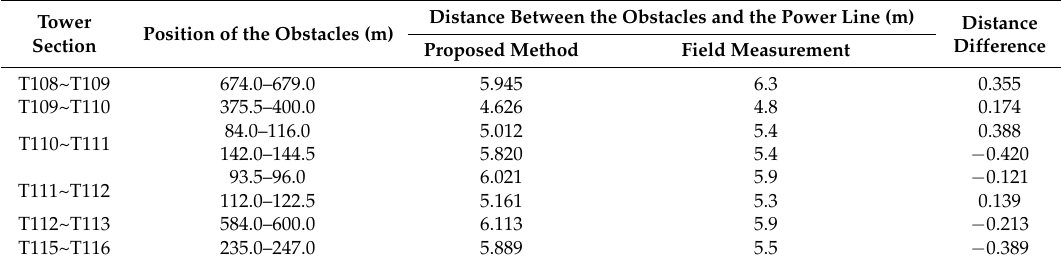
Table 4. Distribution of obstacles within the power line corridor (safety distance threshold: 6.5